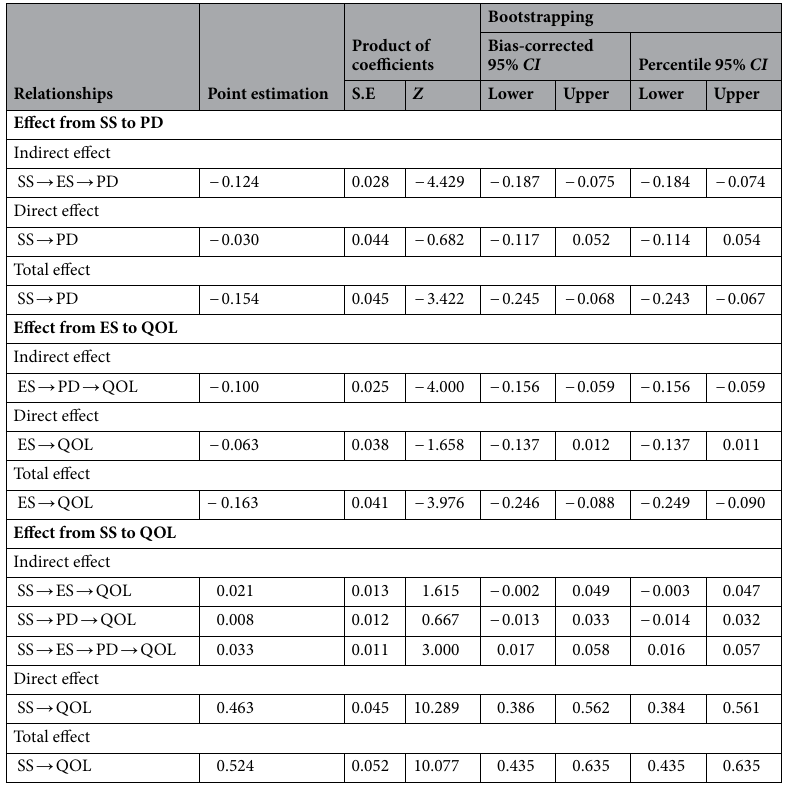
Table 6. Analysis results of mediating variables (5000 bootstrap samples). SS social support, ES experienced stigma, PD psychological distress, QOL quality of life, S.E. standard error, CI confidence